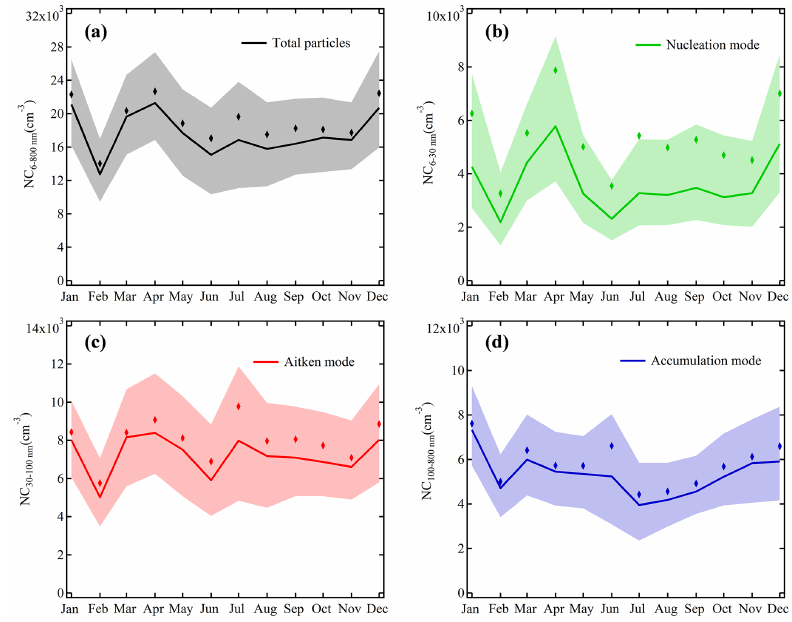
Figure 2. The averaged seasonal variations of (a) the total particle number concentration and number concentrations in the (b) nucleation, (c) Aitken and (d) accumulation modes. Note: bold solid lines are the monthly medians and shaded areas represent the 25th–75th percentile range. The diamond markers represent the monthly average.